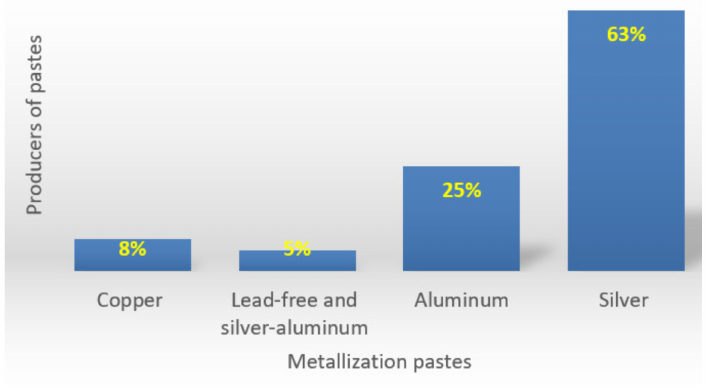
Figure 4. Market survey on metallization pastes [32].